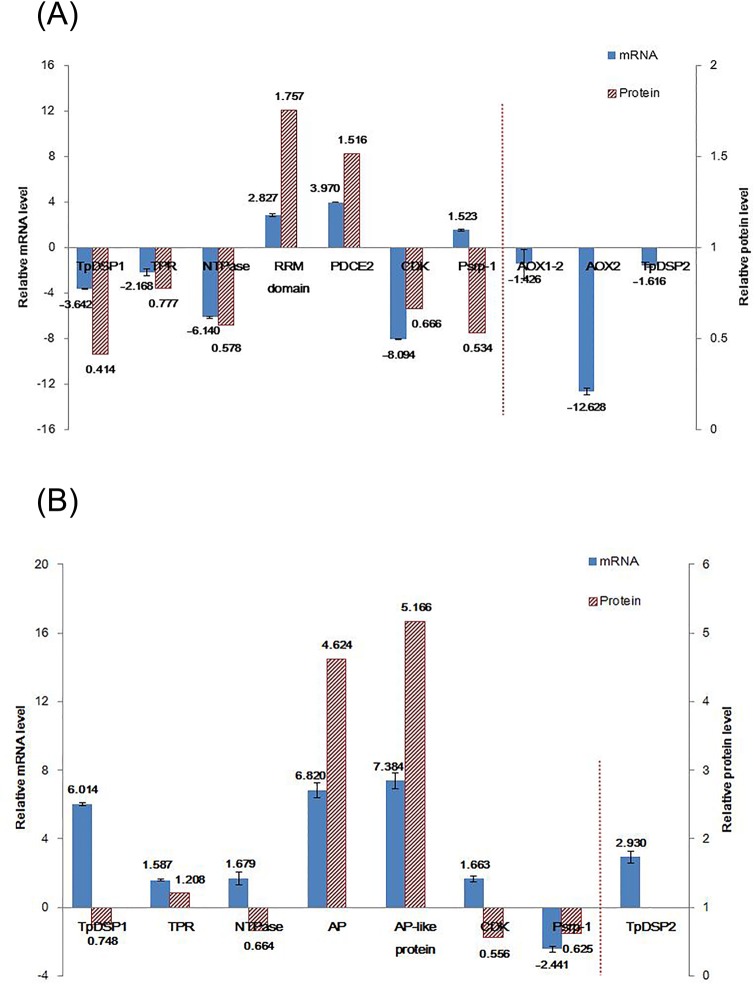
Comparison of mRNA and protein levels of selected genes.Genes include TpDSP1 (Thaps3_11118), TPR (tetratricopeptide repeat protein, Thaps3_22882), NTPase (Thaps3_24162), RRM domain (RNA-binding proteins, Thaps3_21534), PDCE2 (pyruvate/2–oxoglutarate dehydrogenase complex, dihydrolipoamide acyltransferase (E2) component, Thaps3_14235), AP (alkaline phosphatase protein, Thaps3_1179), AP-like protein (Thaps3_1669), CDK (cyclin-dependent kinase, Thaps3_20362), PSrp-1 (ribosome-associated protein Y, Thaps3_255232), AOX1_2 (Thaps3_38428), AOX2 (Thaps3_42992), and TpDSP2 (Thaps3_11117). Translation elongation factor-1α (Thaps3_29435) and ubiquitin-conjugating enzyme (Thaps3_27711) were used as housekeeping markers. Fold changes in the transcript expression for individual genes in N-limited (A) or P-limited (B) cells relative to control are normalized by the geometric mean of the housekeeping markers. The expression of genes unidentified in the present iTRAQ data are indicated in the right of the vertical dotted lines. Left and right vertical axes show relative mRNA and relative protein levels, respectively (mean log2
x-fold expression ratio ± SD from triplicate measurements).